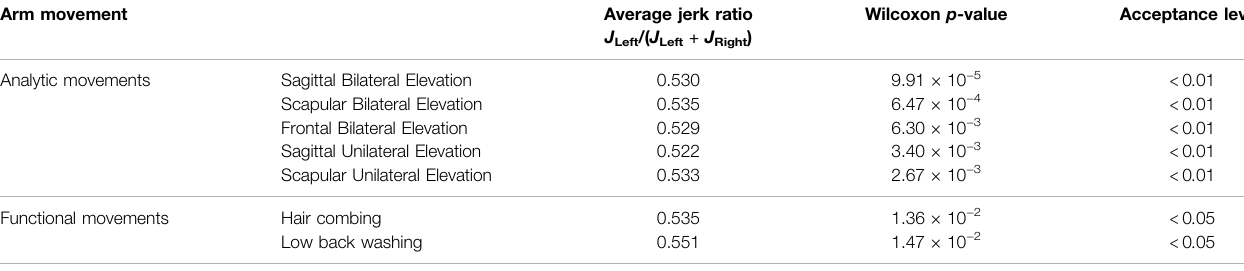
TABLE 4 | Comparisons of jerk metrics between the dominant (right) arm and the non-dominant (left) arm.